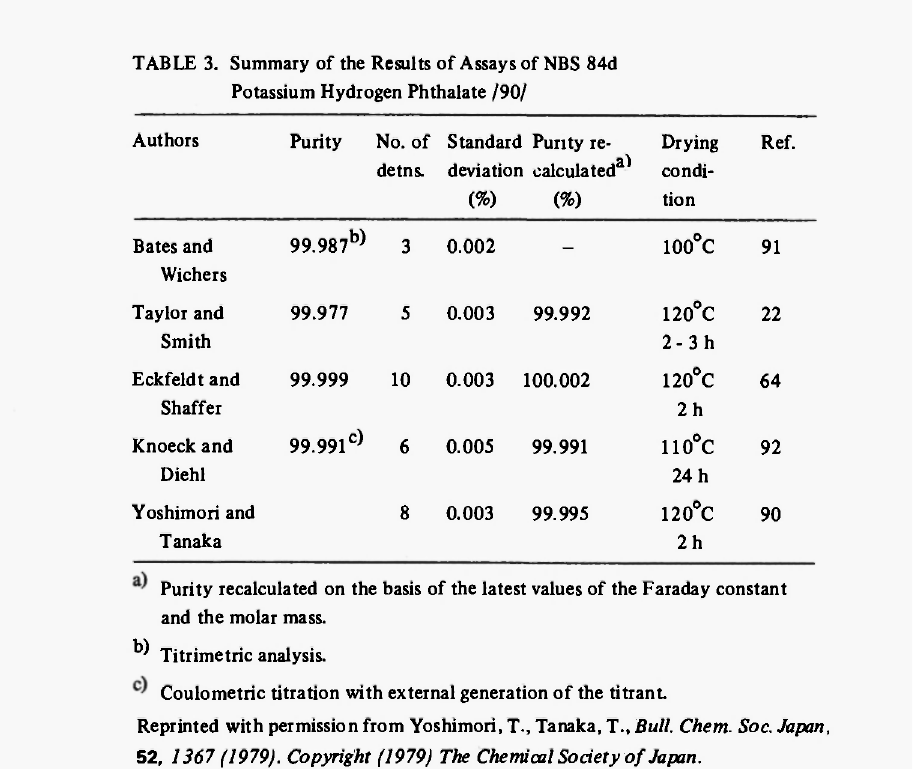
TABLE 3. Summary of the Results of Assays of NBS